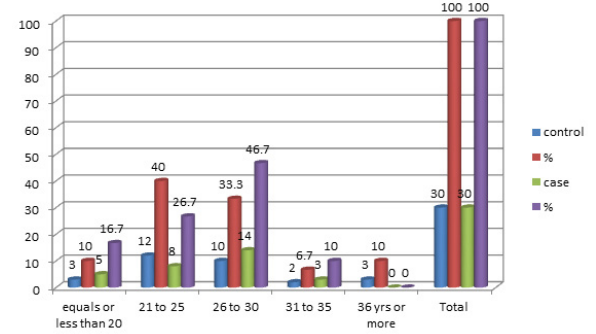
Figure 1: Distribution of HDP and normotensive pregnant women according to age group